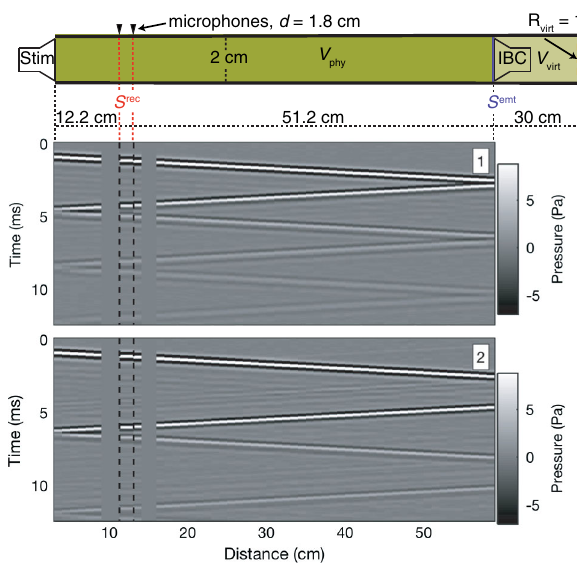
FIG. 8. Top: Geometry of the homogeneous waveguide. A perfectly rigid virtual reflector 30 cm away from the physical termination of the waveguide (orange dashed line) is included in the extrapolation Green ’ s functions. Time-distance panel (1): Reference pressure field obtained by emitting a Ricker wavelet with 2-kHz center frequency with inactive IBCs. Panel (2): Wave field with an active IBC source. Positions immediately next to the recording locations do not contain data due to practical